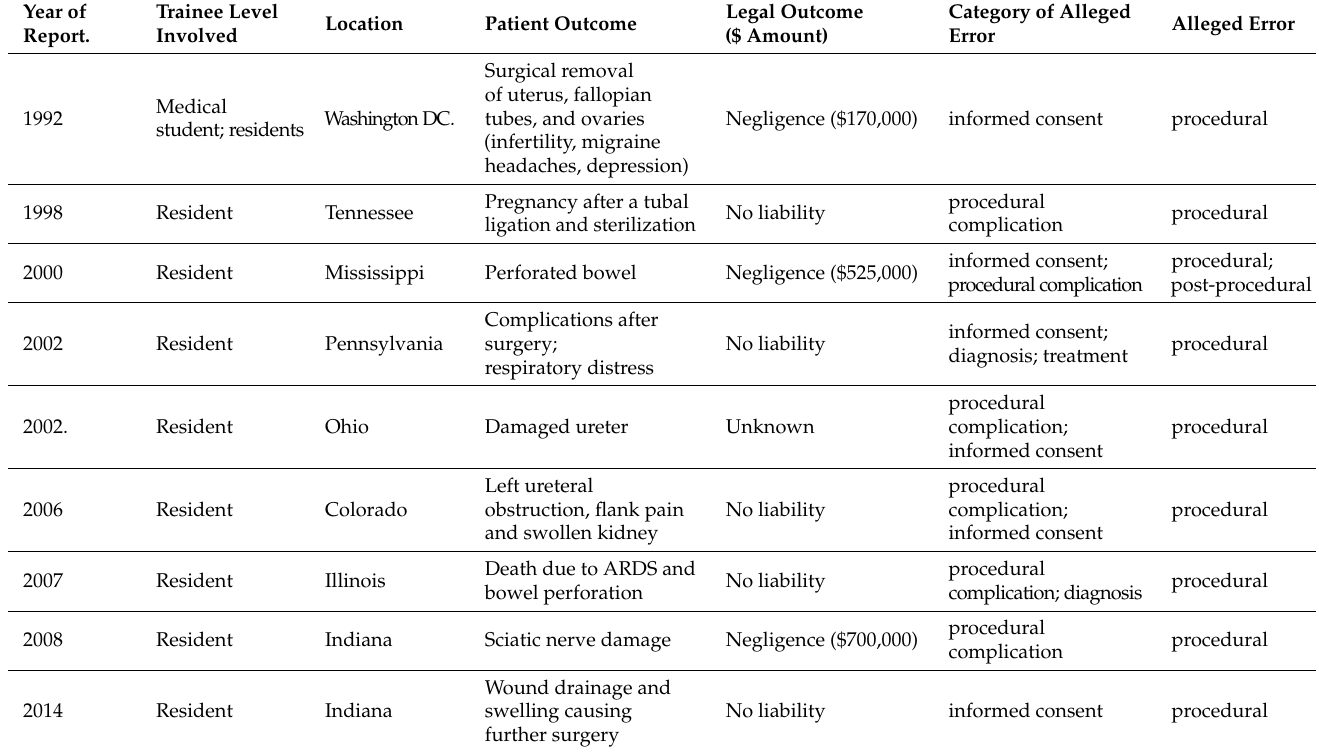
Table 4. Summary table of individual legal cases involving trainees in gynecology. Year of